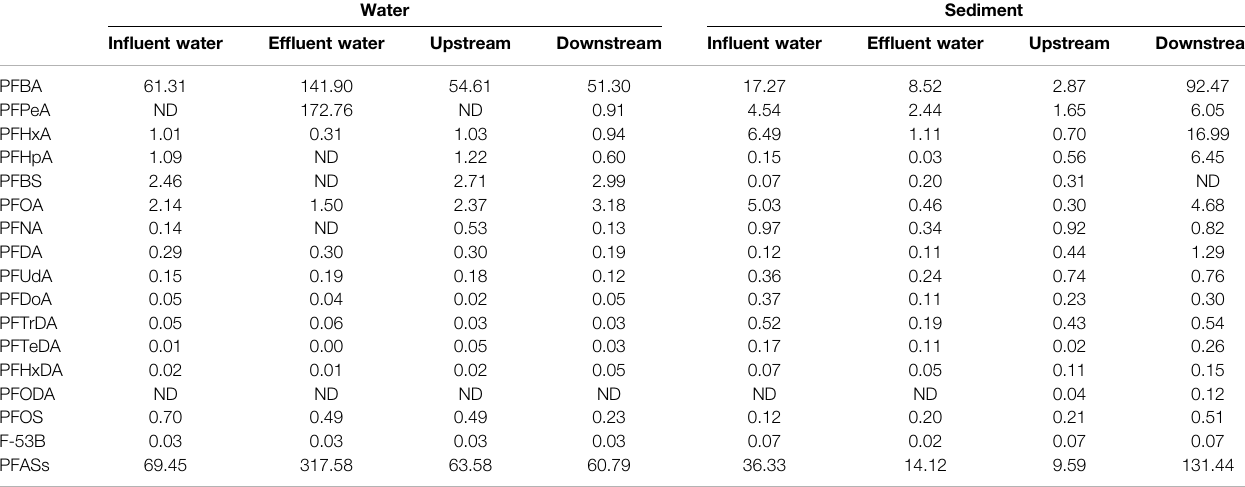
TABLE 1 | Concentration of individual PFASs in water (ng/L) and sediment (ng/g · dw). Water Sediment In fl uent